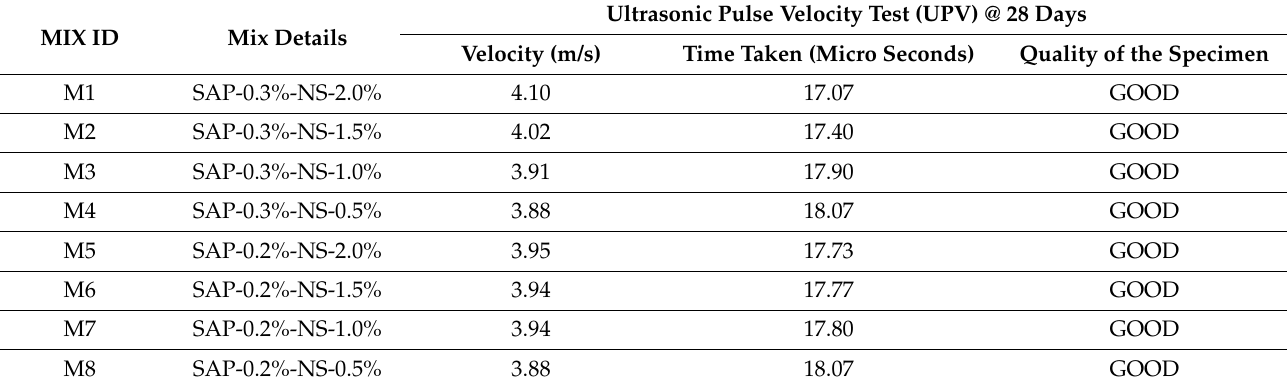
Table 2. Results of UPV test of blended cement mortar.